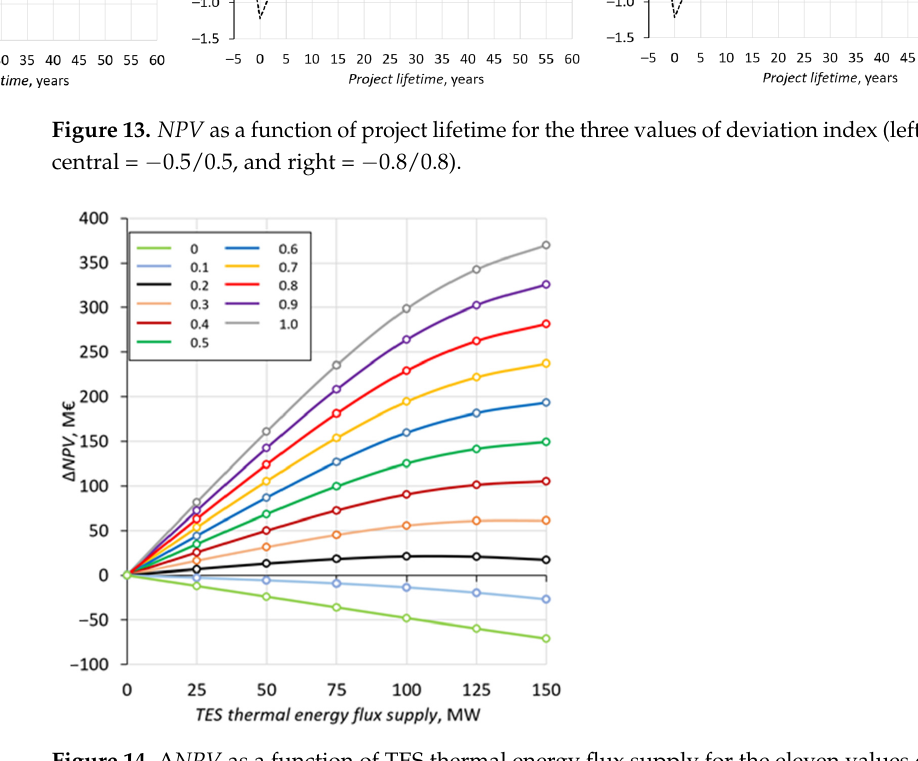
Figure 14. ∆ NPV as a function of TES thermal energy flux supply for the eleven values of deviation index (from 0 to 1, with step 0.1).